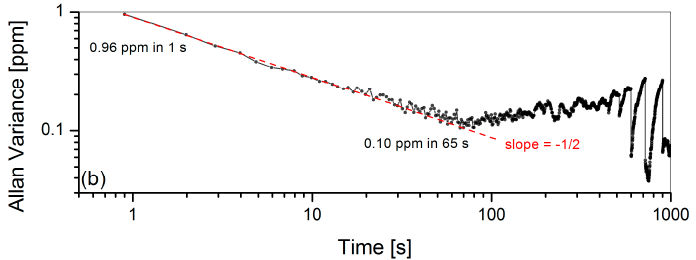
Figure 6. ( a ) Time series measurement; ( b ) Allan deviation plot on a logarithmic scale showing two different behaviors. First, a linear decay at the beginning (slope = − 1/2) indicating linear decrease in deviation with the averaged number of the data, i.e., efficient white noise reduction and hence improvement in the measurement precision. Second, the instabilities of the instrumental system nevertheless counterbalance the noise reduction given by average and the deviation increases due to undesired drift noise.